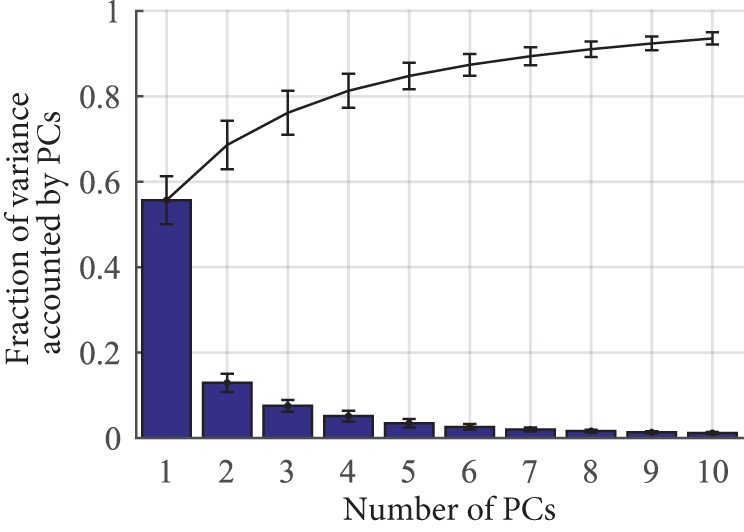
Bars show the mean fraction of variance accounted by each principle component (PC) across subjects. Error bars indicate SD. The line plot shows how these variances accumulate from the first PC to the last PC.